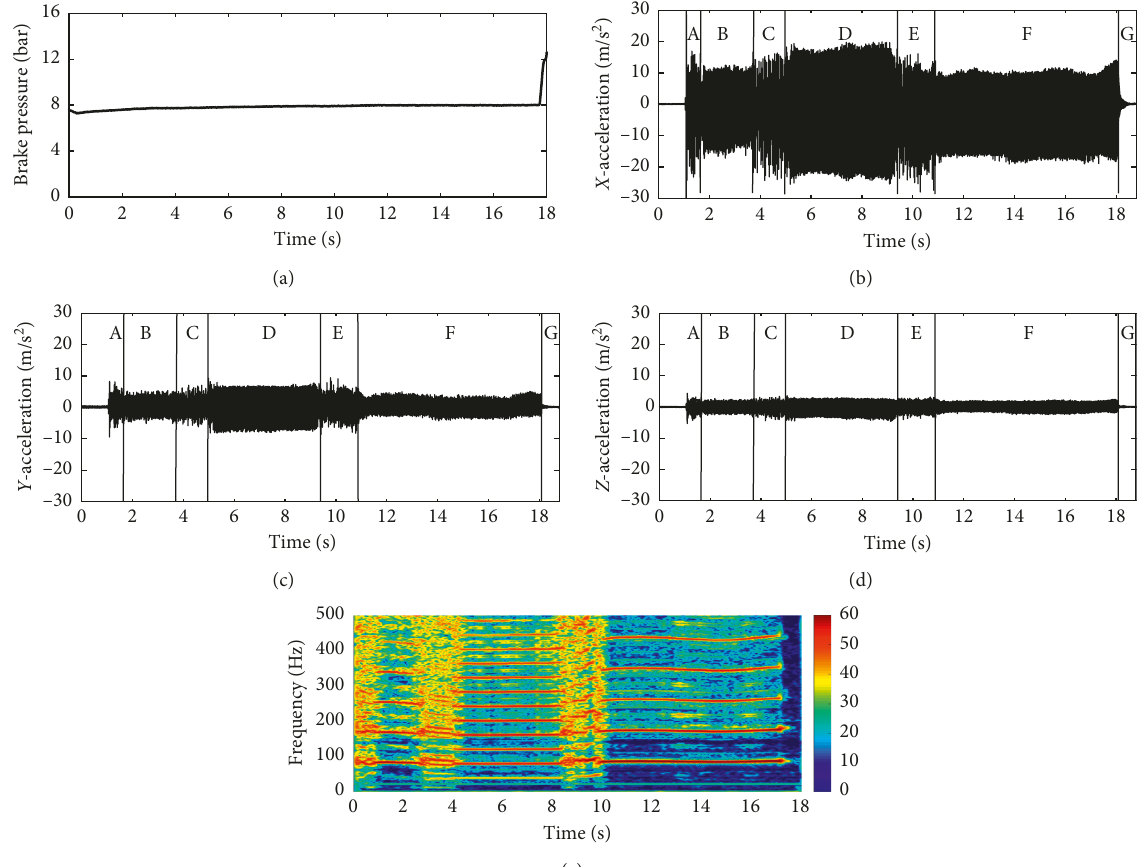
Figure 2: Test results: (a) time history of oil pressure; (b) X-acceleration of caliper; (c) Y-acceleration of caliper; (d) Z-acceleration of caliper; (e) spectrogram of caliper X-acceleration.